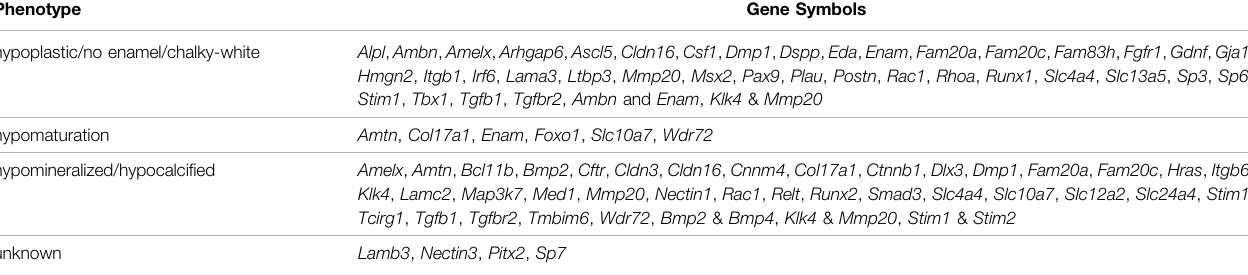
TABLE 3 | Classi fi cation of enamel defects.